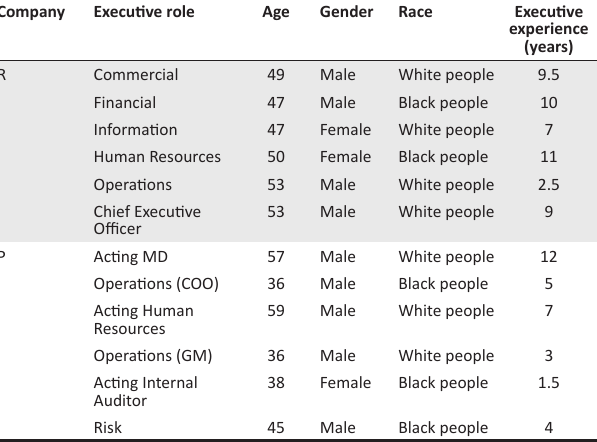
TABLE 2: Profile of executive leaders in Company R and Company